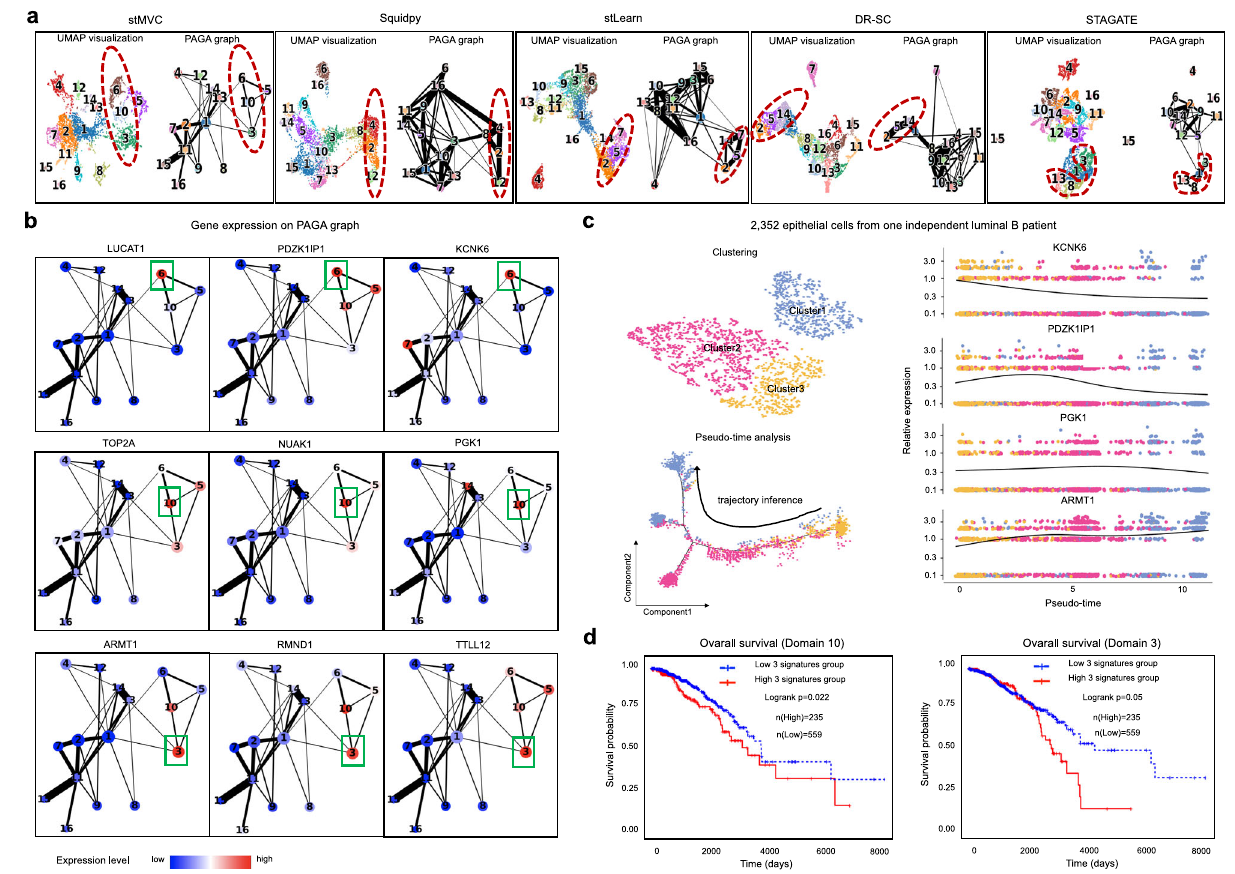
Fig. 4 | stMVC is able to identify tumor-related cell-states and their transition cell-states from the invasive carcinoma region in the breast cancer sample. a UMAP visualization and PAGA graph generated by the low-dimensional features by stMVC, Squidpy, stLearn, DR-SC, and STAGATE, respectively. The predicted clustersforeachmethodarethesameasinFig.3i. b Geneexpressionlevelsofnine marker genes for three different cell-states on the PAGA graph by the low- dimensional features of stMVC. c Visualization of the clustering and trajectory inferencefrom2352epithelialcellsofCID4067(anindependentluminalBpatient), and pseudo-time-dependent changes in expression levels of KCNK6 , PDZK1IP1 ,